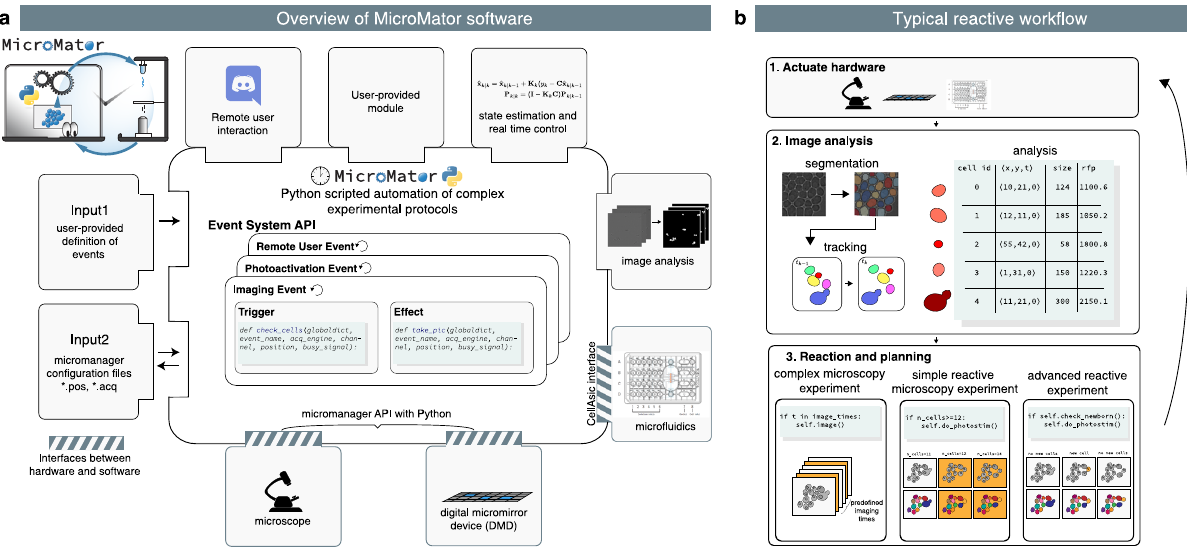
Fig. 1 MicroMator overview. a Modular software architecture. MicroMator consists of a core software that handles user-de fi ned events and of an extensible set of modules that control various hardware and software aspects of microscopy experiments. It is written in the high-level programming language Python. It takes as inputs Python fi les de fi ning events and Micro-Manager con fi guration fi les providing positions of interest and an imaging backbone. b Event-based reactive microscopy work fl ow. Imaging can be followed by online analysis of the samples. This typically involves segmentation, tracking, quanti fi cation of cell properties, and possibly advanced additional computations. Effects may then be triggered based on the result of the analysis. These may include the physical actuation of the hardware or the initiation of communications or of additional